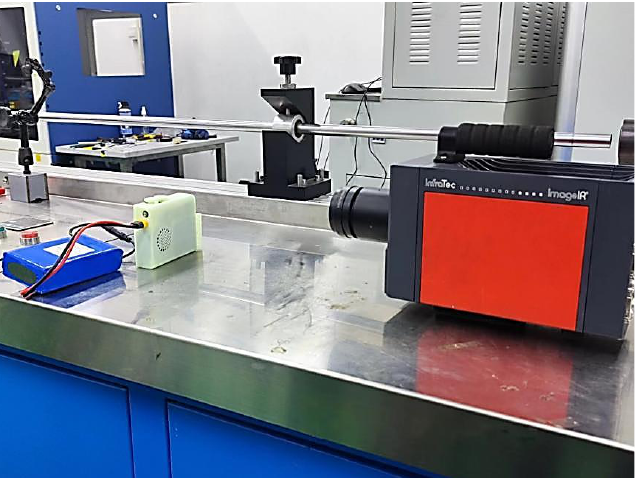
Figure 14. Placement of infrared thermal imager and refrigeration device.